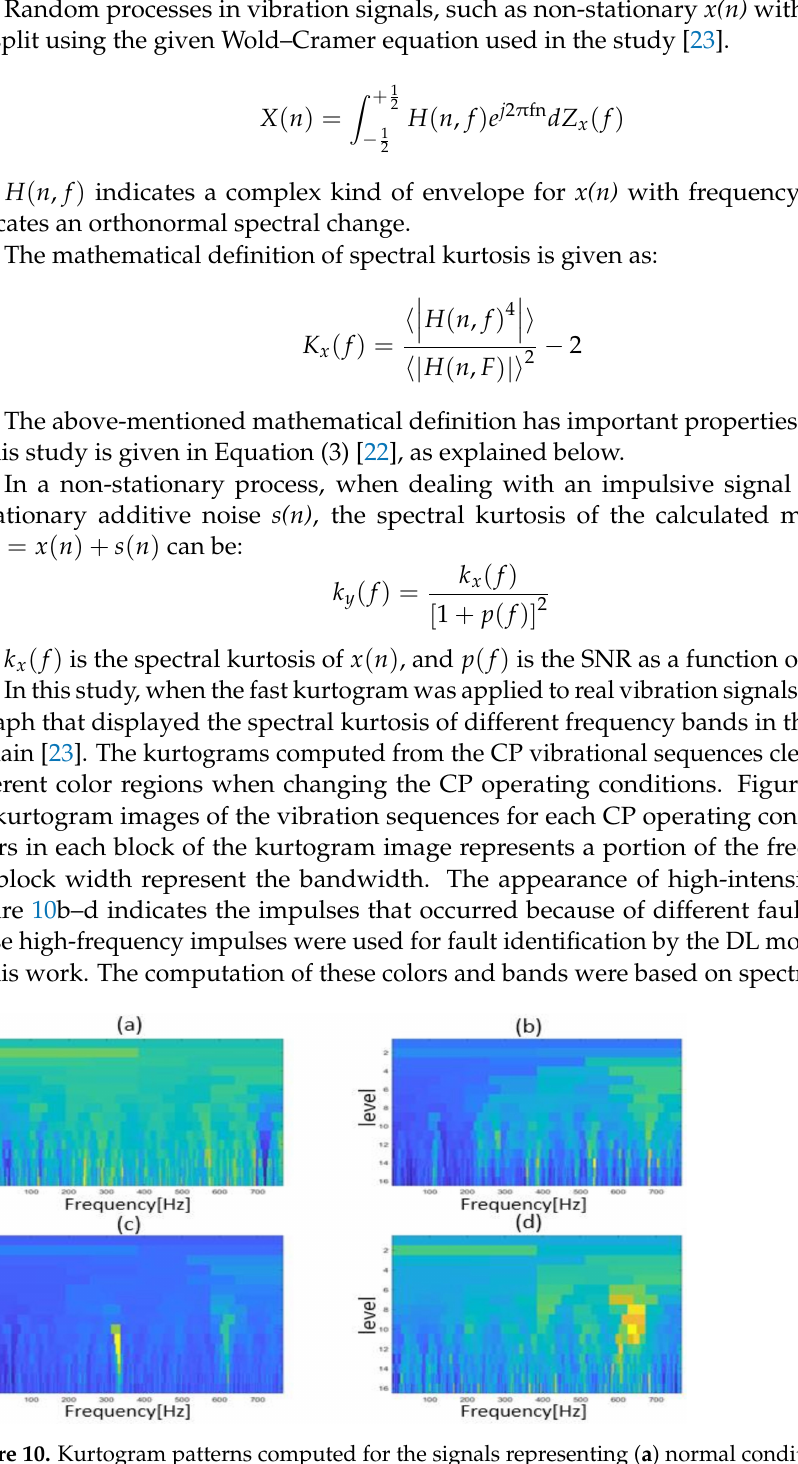
Figure 10. Kurtogram patterns computed for the signals representing ( a ) normal conditions, ( b ) MSS fault, ( c ) MSH fault, and ( d ) impeller defect under a 3.0 bar